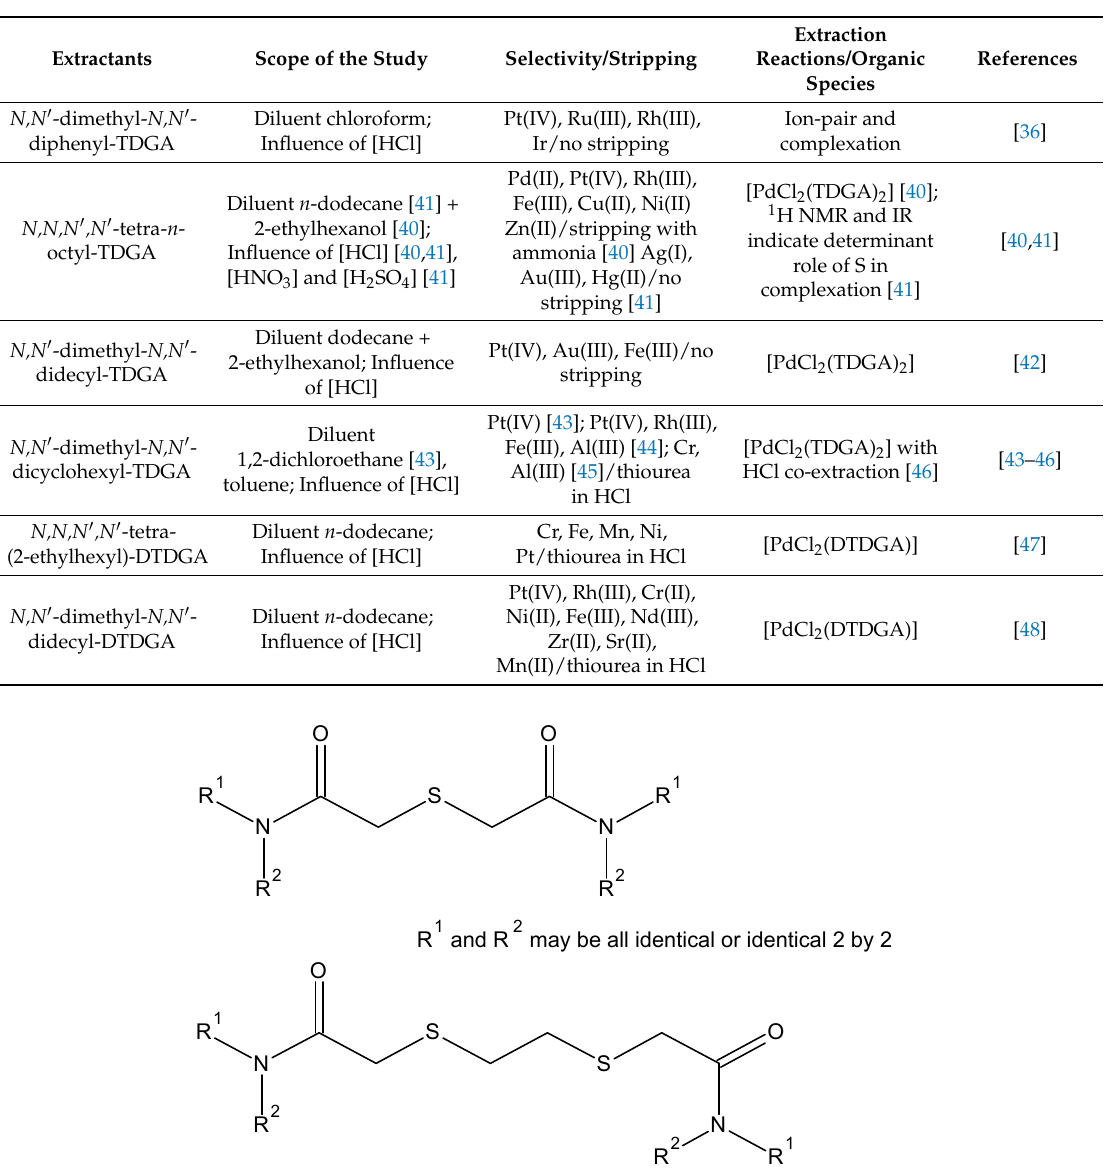
Figure 4. The general structures of TDGAs and DTDGAs ( N,N,N ′ ,N ′ - tetrasubstituted thio- and dithio-diglycolamides, respectively).